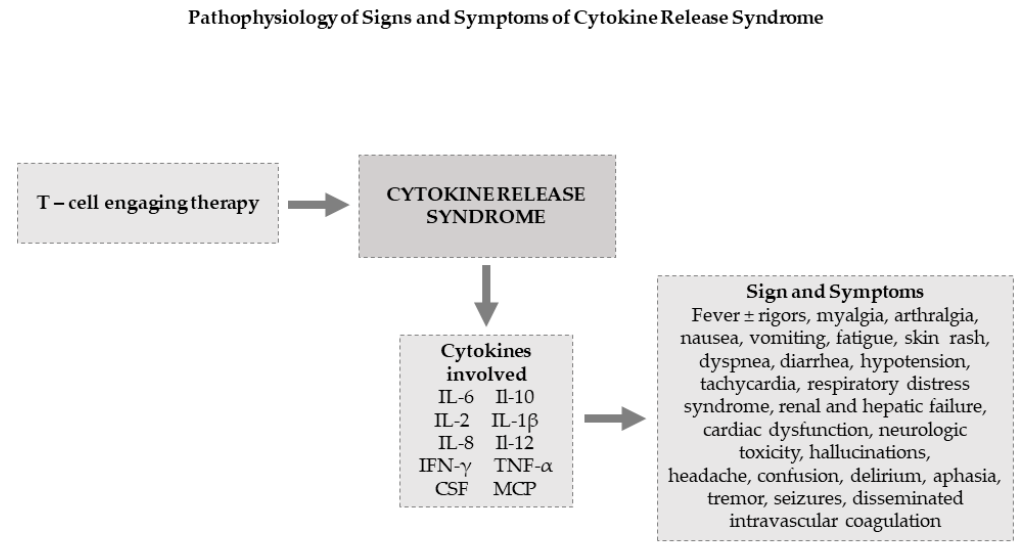
Figure 3. Pathophysiology of signs and symptoms of CRS. IFN- γ : interferon-gamma; TNF- α : tumor necrosis factor-alpha; IL: interleukin; CSF: colony-stimulating factor; MCP: monocyte chemoattractant protein.